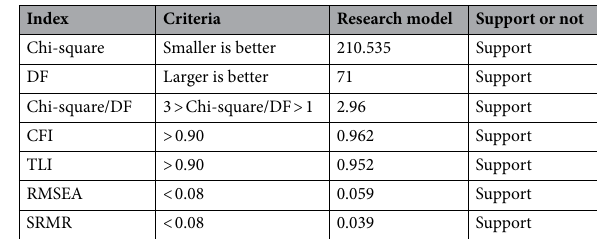
Table 3. Fitting index of the research model. DF degrees of freedom, CFI comparative fit index, TLI Tucker– Lewis index, RMSEA root mean squared error of approximation, SRMR standardized root mean square